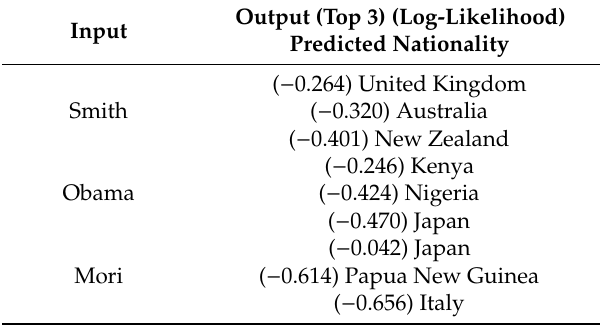
Table 1. Prediction results.